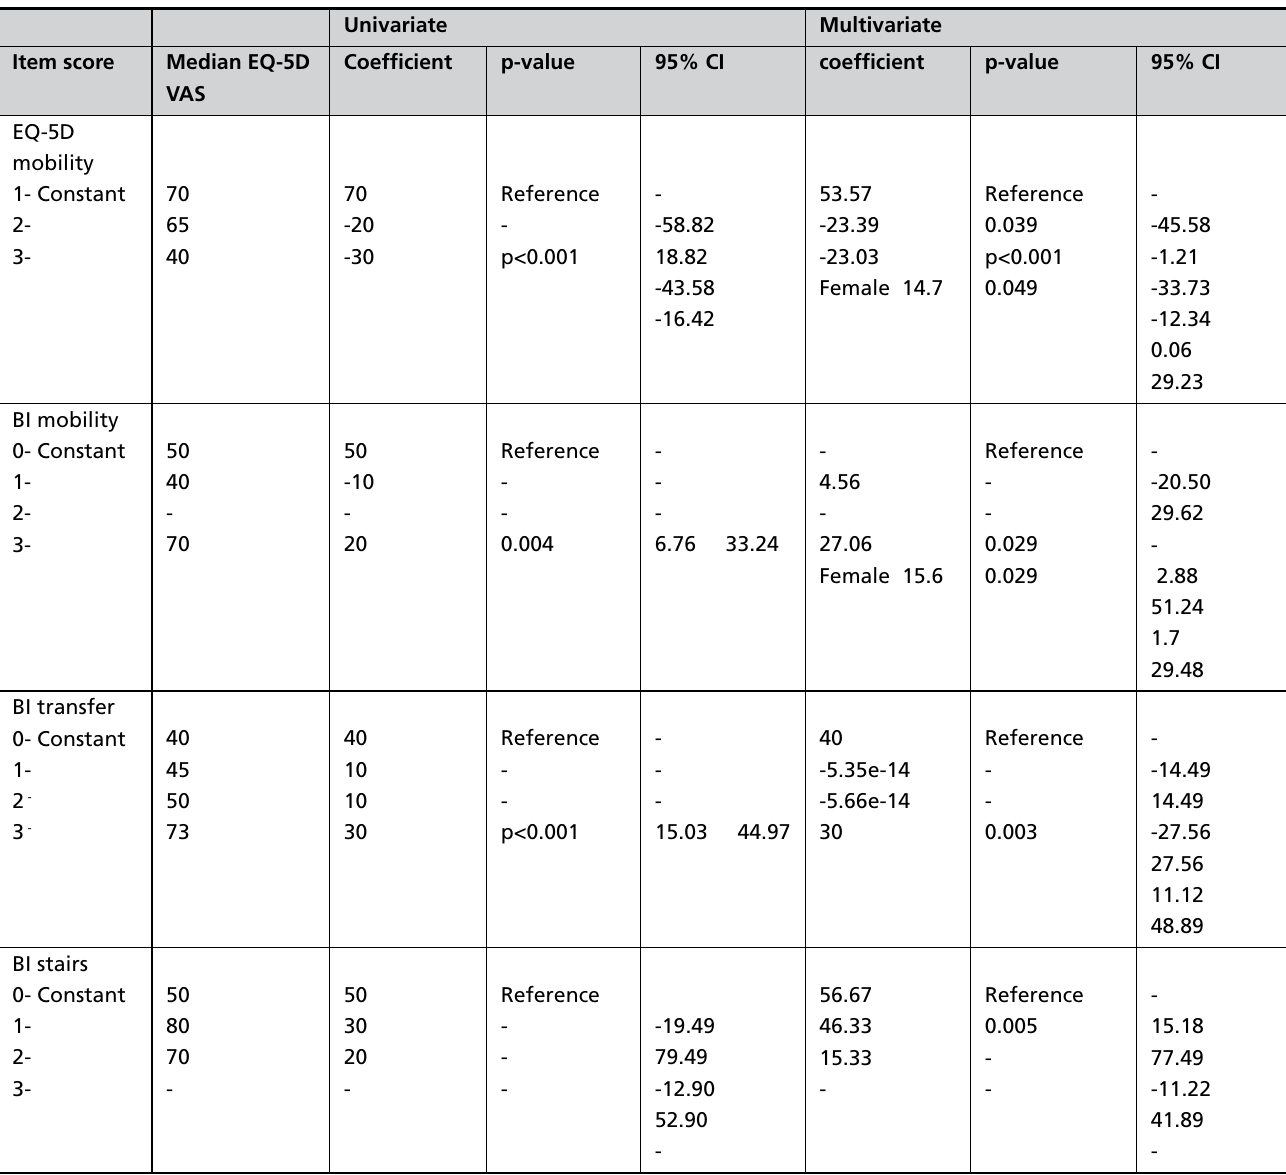
Table 5: factors affecting QoL, a VAS median regression analysis (n=